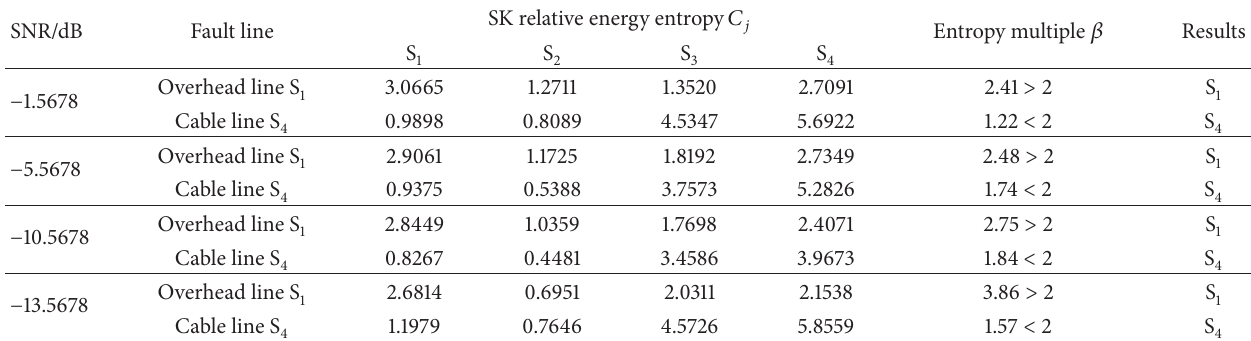
Table 9: SK relative energy entropy with different intensity noise ( 𝜃 = 0 ∘ , 𝑅 = 20Ω